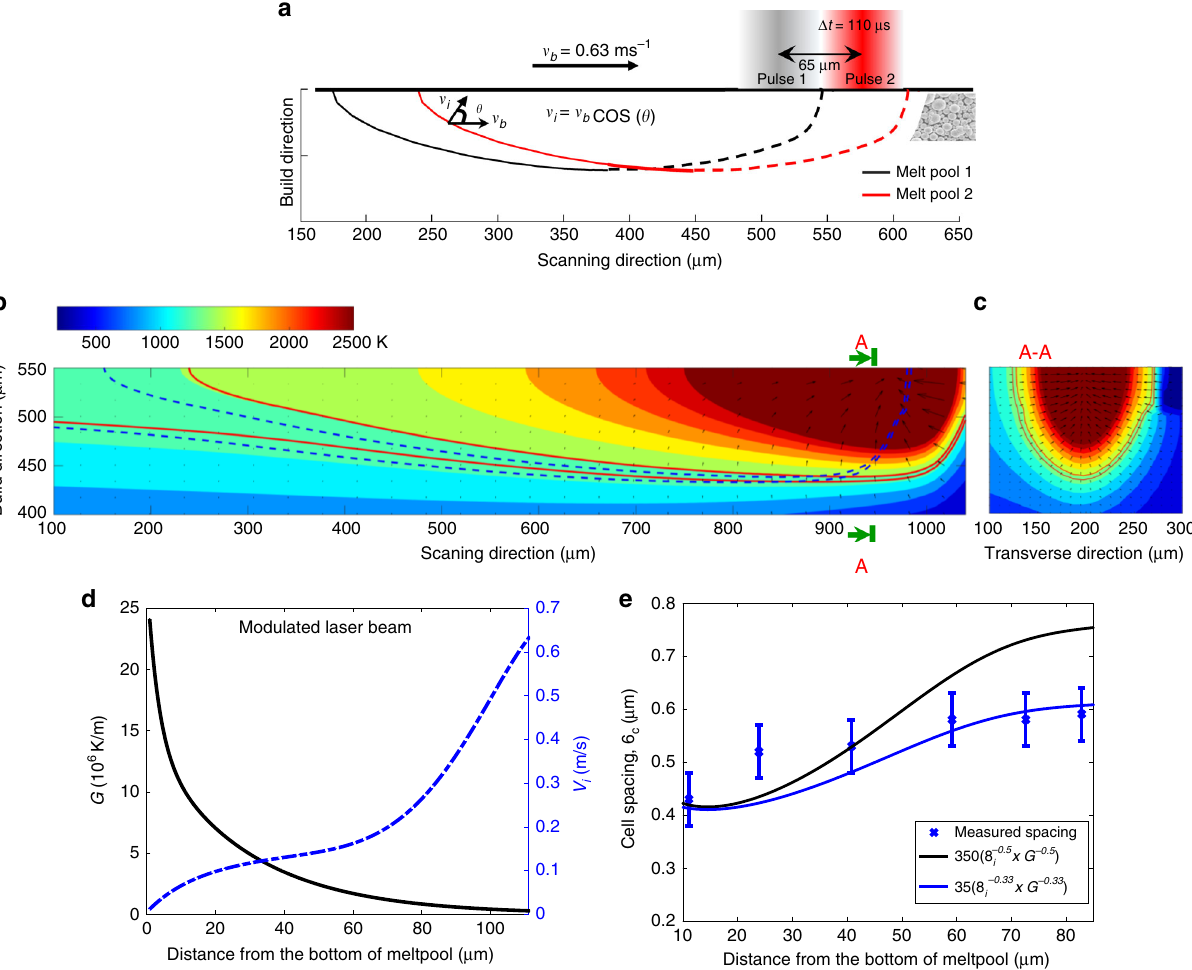
Fig. 2 Thermal pro fi le in a melt pool of 316L. a Schematic diagram of two adjacent melt pools (dash lines represent the melting front while the solid lines are for the solidi fi cation front); v b and v i are the velocities of the beam and the solidi fi cation front, respectively; Δ t is the pulsing time of the laser beam. b Side-view (parallel to a deposition track) of two consecutive melt pools: the inner and outer solid lines are, respectively, the liquidus and solidus temperatures of the current melt pool while the dashed lines are for the most previous melt pool). The direction and length of vectors represent the direction and magnitude of G . c A-A section transverse to a deposition track (note: kinks of isotherms on the right of melt pool were due to local changes in heat conduction intentionally introduce to mimic the presence of unmelted powder). d The variations of G (solid line) and v i (dotted dash line) along the liquidus front from the bottom towards the top of a melt pool. e Variation of cell spacing: Experimental measurement (error bars represent one standard deviation of uncertainty) of cells shown in Fig. 1d vs. fi ting ð v (cid:2) m i G (cid:2) n Þ along the distance from the bottom of a melt pool (Note: the identi fi ed prefactor of 35 for ð v (cid:2) 0 : 33